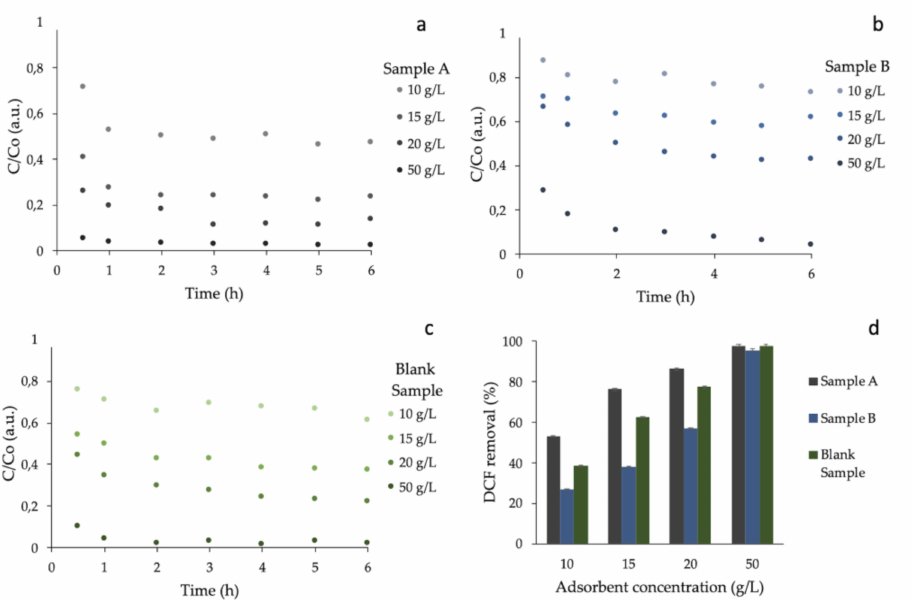
Figure 3. Variation of DCF concentrations (normalized to C 0 ) with respect to the variation of time at 4 di ff erent adsorbent amounts for sample A ( a ), sample B ( b ), and a blank sample ( c ). We also reported the comparison of DCF removal (%) at the end of each experiment (t = 6 h) for the three materials ( d ). An instrumental error equal to 0.6% for the experimental data was considered. Error bars are included within the experimental point size (a, b, and